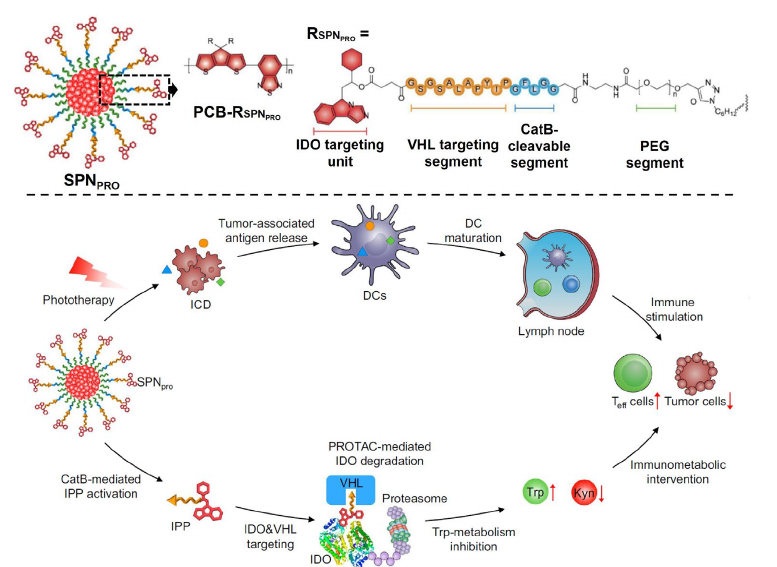
Figure 7. PROTAC delivery systems for cancer immunotherapy. The combinational cancer immu- notherapy was carried out using semiconducting polymer nano-PROTACs. The semiconducting polymers in nano-PROTACs induced PDT-mediated ICD. IDO-degrading PROTACs were cathep- sin B- specifically released from nanoparticles and inh ibited the Tryptophan metabolism, repro- gramming the immunosuppressive TMEs. Reproduced with permission [159]. Copyright 2021, Na- ture Publication Group.